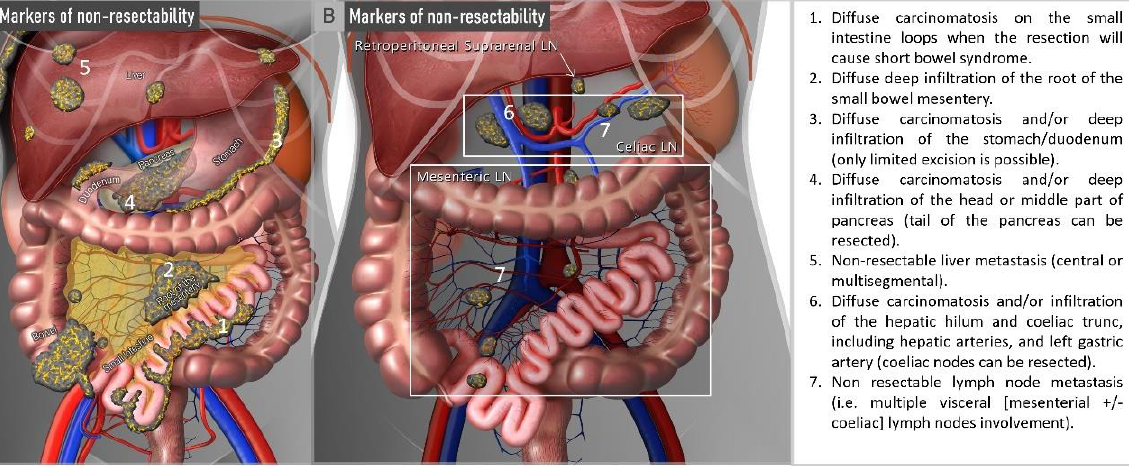
Figure 2. ESMO-ESGO markers of non-resectability. Non-resectable disease is defined by one or more markers published by ESMO-ESGO [31]. ESGO, European Society of Gynaecological Oncology; ESMO, European Society for Medical Oncology.